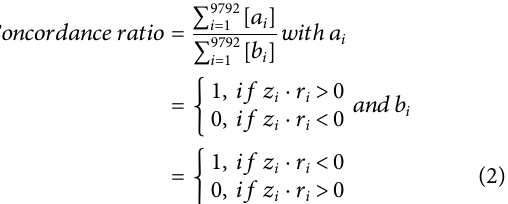
Frontiers in Pharmacology |